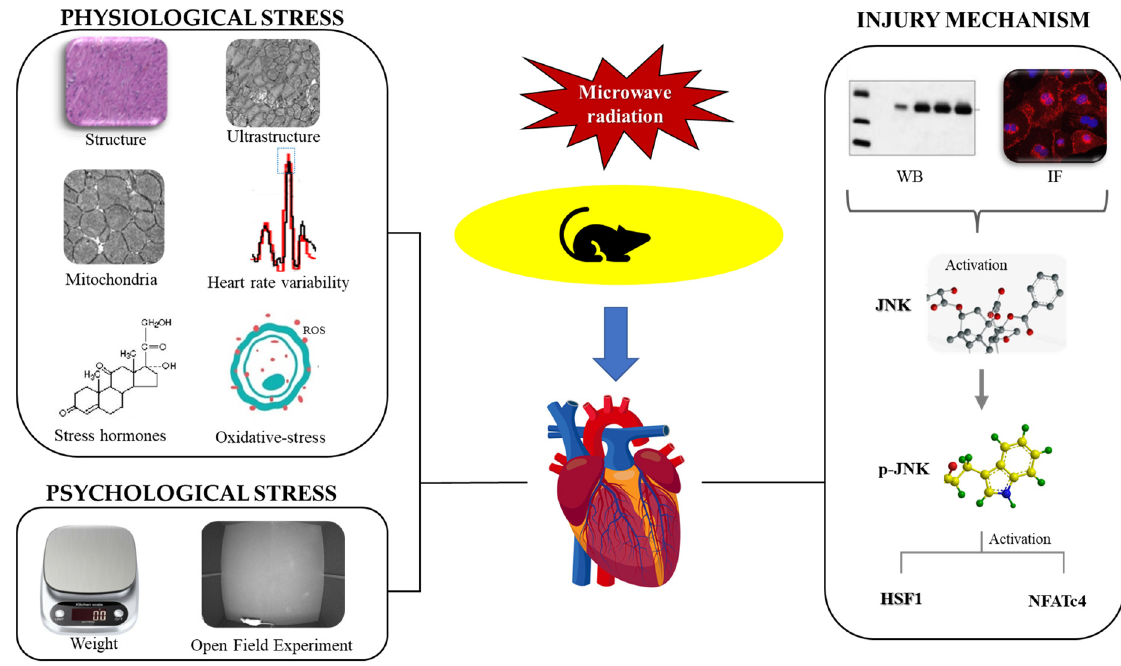
Figure 18. Diagram of research ideology.